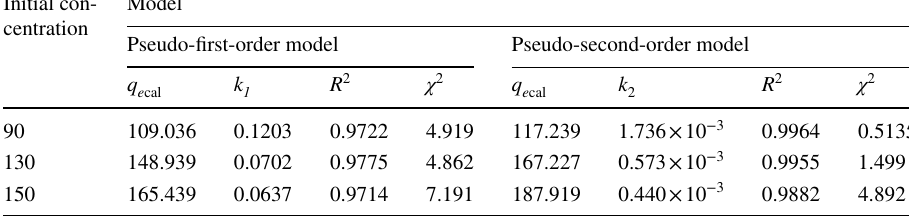
Table 5 Pseudo-first-order and pseudo-second-order models constants, correlation coefficients, and Chi-square statistical test for BA25 dye adsorption onto WDS-AC